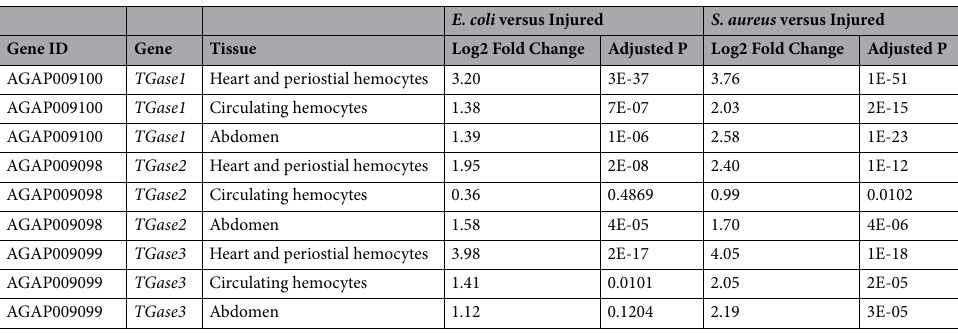
Table 1. Regulation of transglutaminase gene expression in the periostial hemocytes, circulating hemocytes and abdomen at 4 h following GFP- E. coli or S. aureus infection a . a Data mined from SRA data PRJNA730047 in NCBI (https:// www. ncbi. nlm. nih.